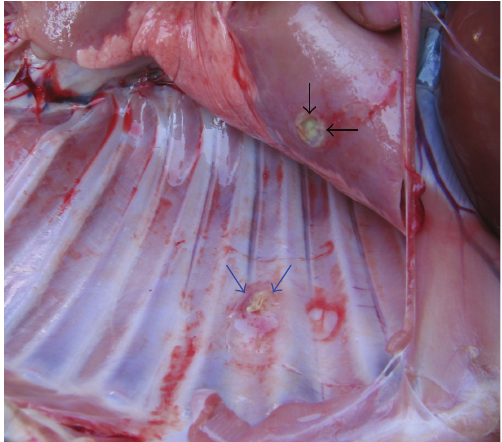
Figure 2: Close up of the chest cavity of the lamb in Figure 1. An abscess (black arrows) in the lungs and focal adhesions of the lungs to the pleura (blue arrows, ruptured postmortem) are